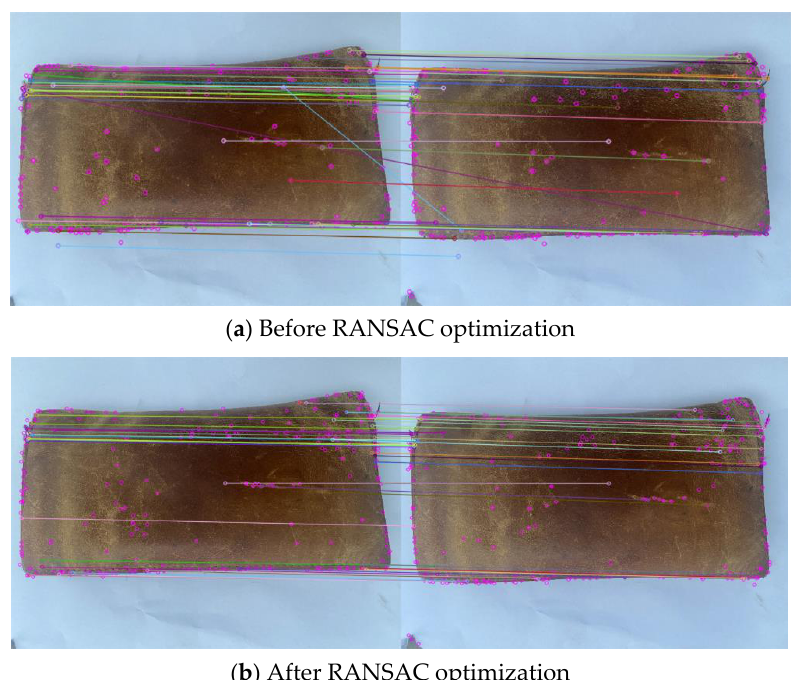
Figure 9. ( a , b ) are the experimental diagrams of feature matching before and after RANSAC optimization.